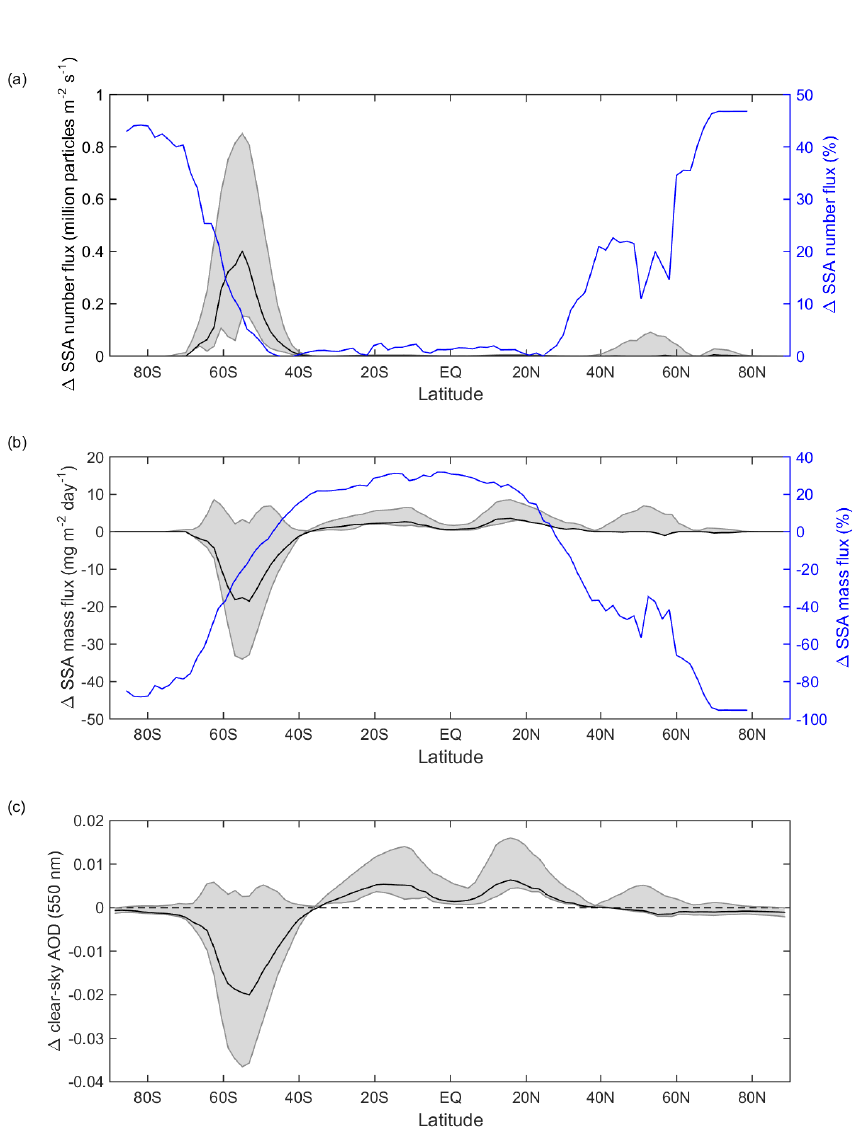
Figure 7. Zonal plots of the annually averaged (median) absolute difference in (a) SSA number fluxes, (b) SSA mass fluxes, and (c) clear- sky aerosol optical depth at 550nm between the parameterisation developed here with climatology sea surface temperatures and sea surface temperature fixed at 15 ◦ C. Each plot was generated as the variable sea surface temperature simulation minus the fixed sea surface temperature simulation. Shaded areas represent 25th and 75th percentiles and the blue lines in (a) and (b) show percentage changes and refer to the right